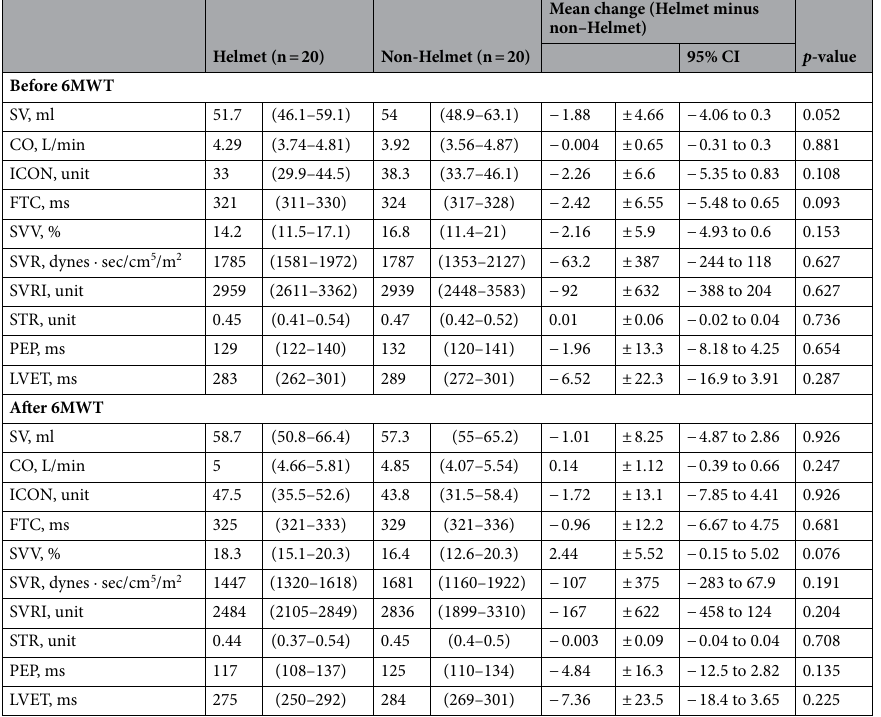
Table 3. Hemodynamic outcomes. Data are presented as mean ± SD or median (IQR). SV stroke volume, CO cardiac output, ICON index of contractility, FTC correct flow time, SVV stroke volume variation, SVR systemic